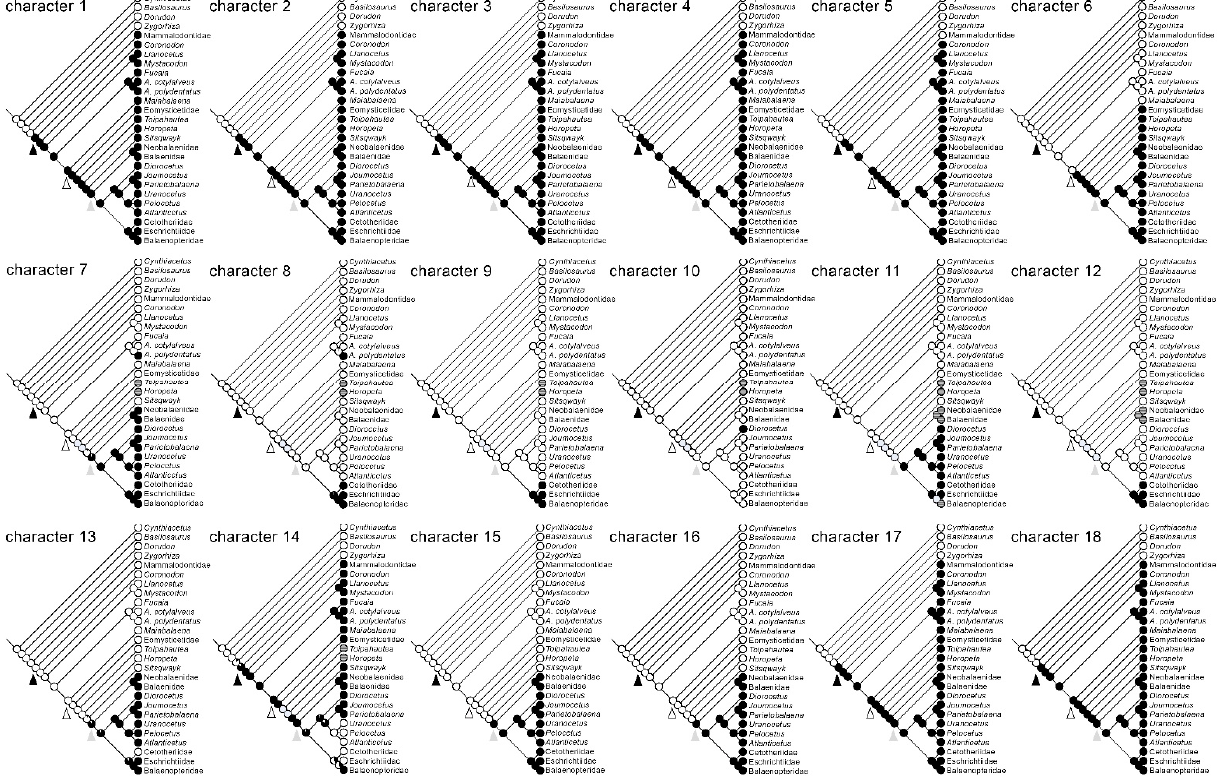
Figure 26. Analysis of the distribution of characters 1–18 of Table 2 in the phylogeny of Figure 1. The black triangle corresponds to the Mysticeti node, the white triangle corresponds to Chaeomysticeti and the gray triangle corresponds to Balaenomorpha.